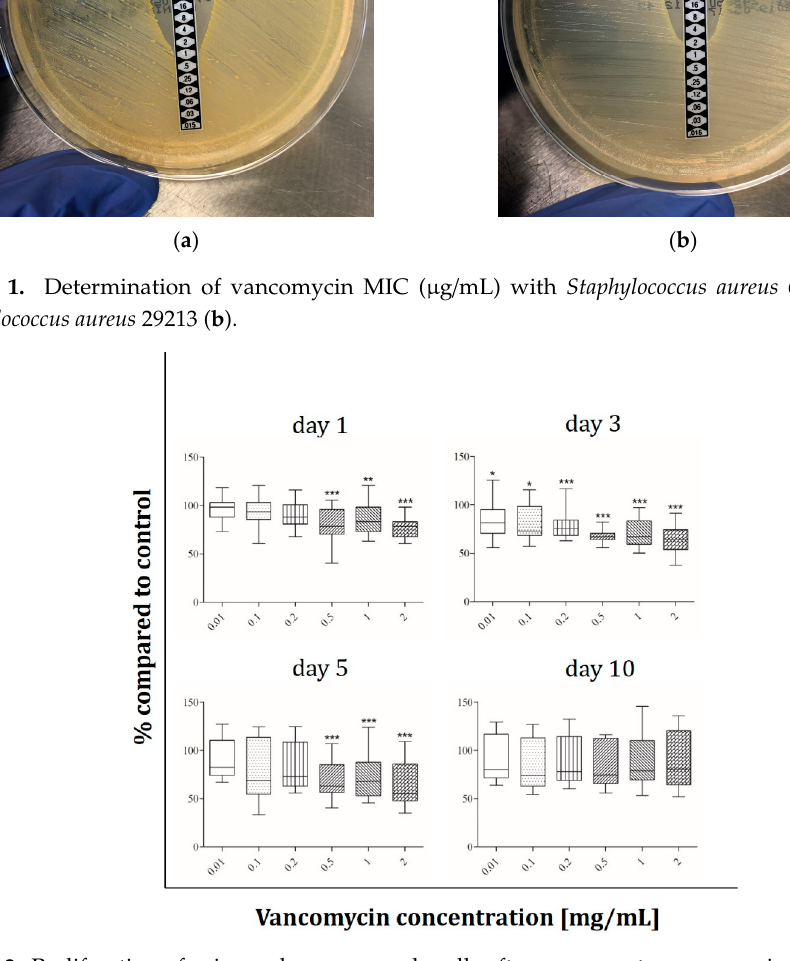
Figure 2. Proliferation of primary human muscle cells after exposure to vancomycin for 1, 3, 5 and 10 10 days with change of antibiotic every four days (* p < 0.05; ** p < 0.01; *** p < 0.001 to days with change of antibiotic every four days (* p ˂ 0.05; ** p < 0.01; *** p < 0.001 to control). The results are presented in percentage of the control without vancomycin (100%).